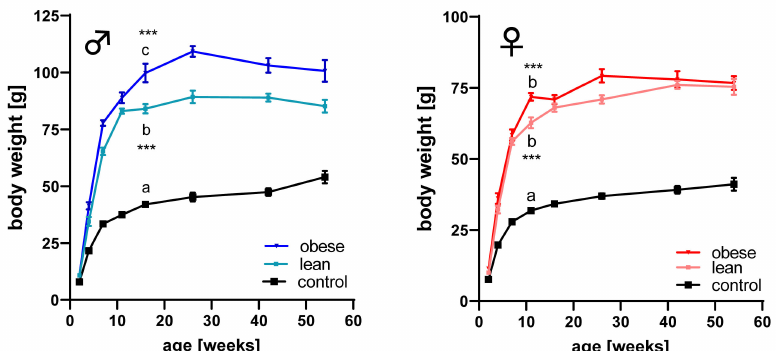
Figure 1. Body weight in male (left panel) and female (right panel) mice selected for high body weight (obese), for high protein amount (lean), and in unselected controls at an age of 2, 4, 7, 11, 16, 29, 42, and 54 weeks. (mean ± SEM; n = 8; due to high mortality, sample number was reduced to n = 4 at an age of 54 weeks in male obese mice; di ff erent letters (a, b, and c) indicate significant di ff erences also in di ff erent genetic groups per gender, ***: p < 0.001; identical letters indicate no statistically significant di ff erence).